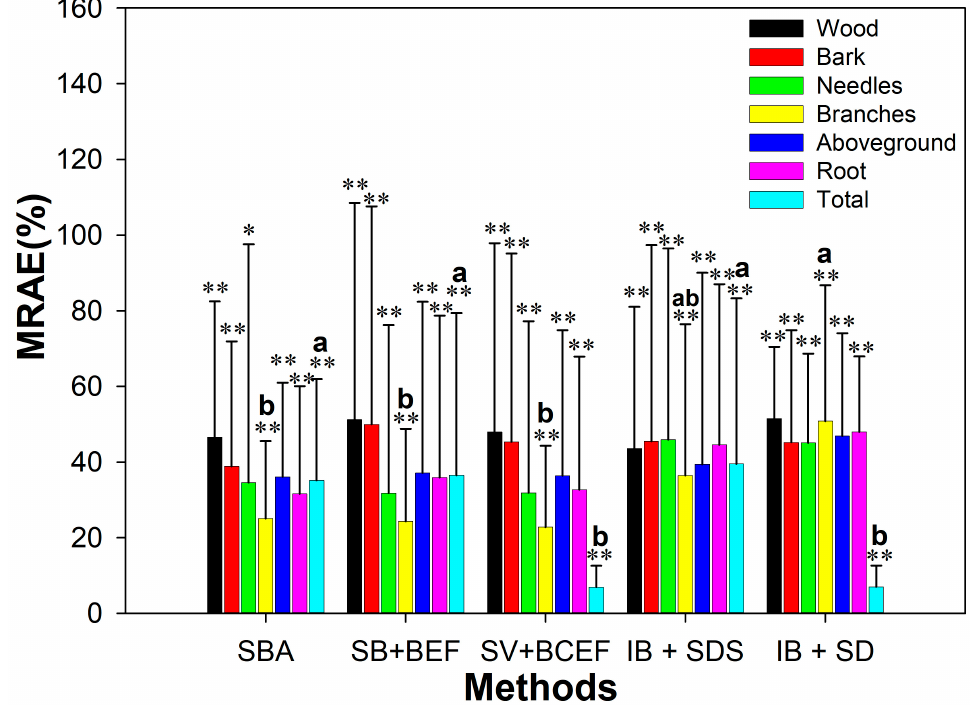
Figure 4. Mean relative absolute error (MRAE) of five methods for the different components. The statistical test results of the significant differences of MRAEs from zero: * and ** represent the significance levels of 0.05 and 0.01, respectively. The letters a, ab, and b indicate the significance of the same component between different methods at the significance levels of 0.05.